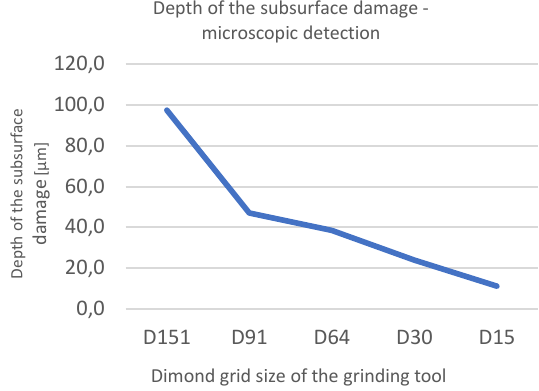
Fig . 13 . Depth of the subsurface damage inspected by the referenc microscope based method.